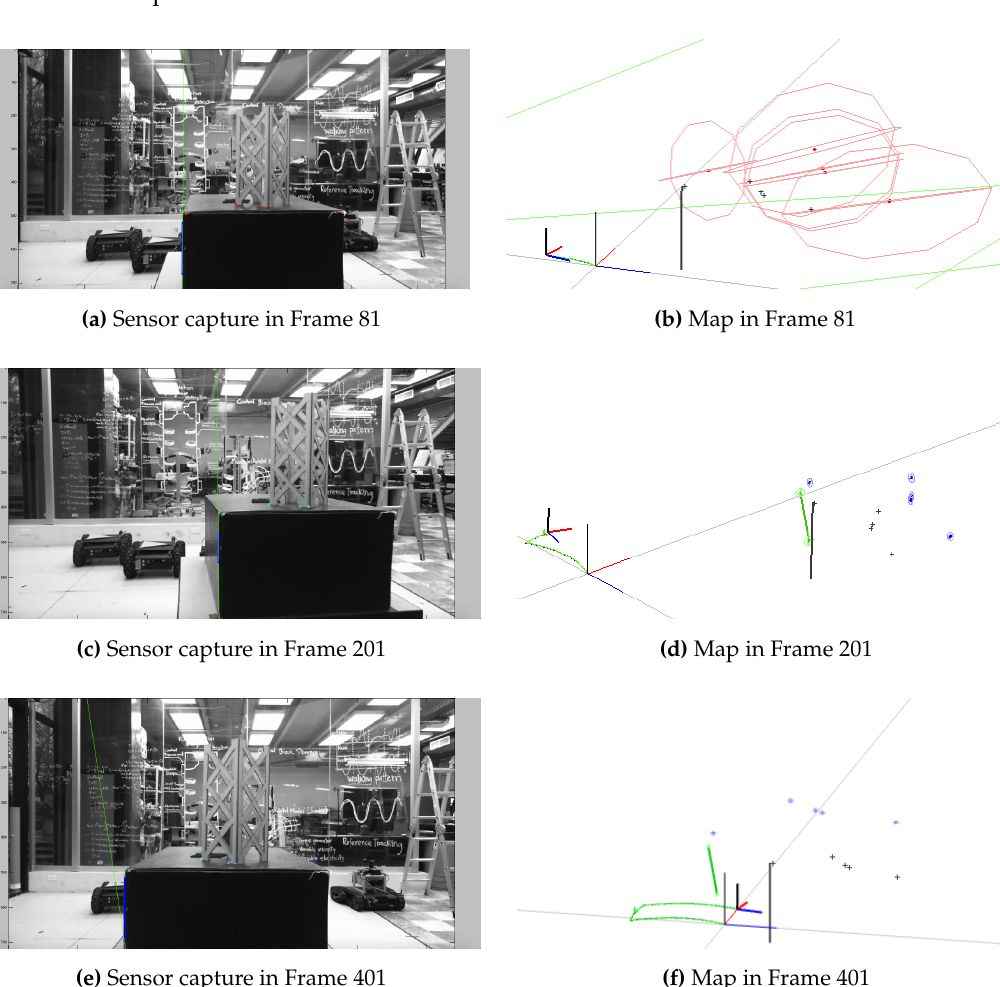
Figure 13. Point and line heterogeneous EKF-SLAM frames. ( a , c , e ) The front-end part; infinite thin lines represent the estimated position of the landmark in the current image, while thicker segments show the match found; circles represent the prediction of points, and points themselves are the match found; ( b , d , f ) The maps created on each frame, with the landmarks’ estimation, the current pose of the camera represented by the small reference frame and the trajectory